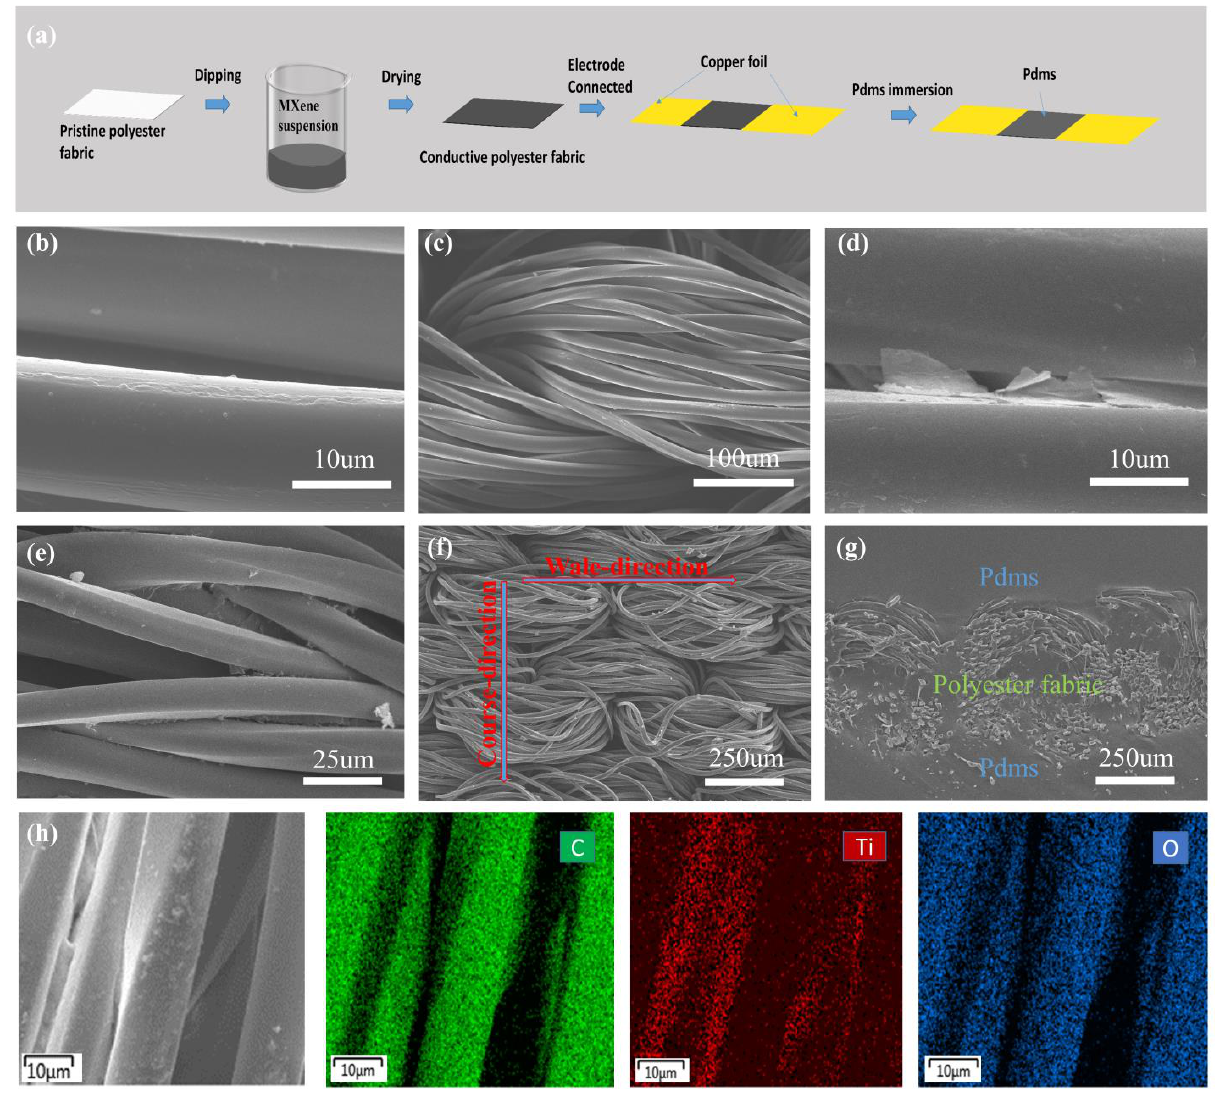
Figure 2. ( a ) Schematic illustration of the PMPF strain sensor fabrication process; ( b , c ) SEM images of the surface of the clean polyester fabric at different magnifications; ( d – f ) SEM images of the surface of the MXene@polyester fabric at different magnifications; ( g ) SEM image of the fractured surface of the PMPF strain sensor; ( h ) SEM image of the MXene@polyester fabric strain sensor and the corresponding EDX elemental mapping (green: C, red: Ti, blue: O).